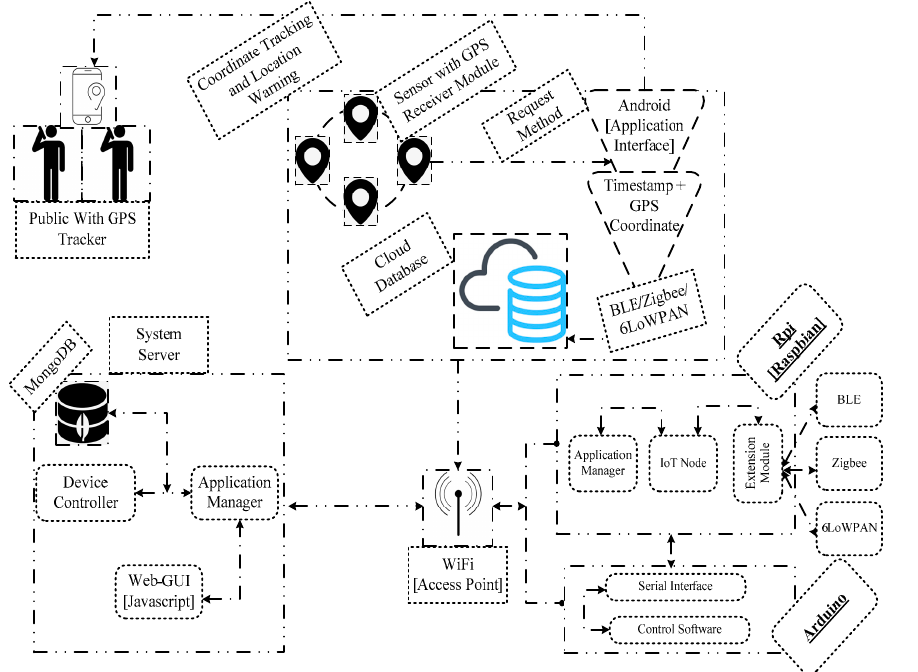
Figure 6. Testbed of intelligent Edge-IoT model.